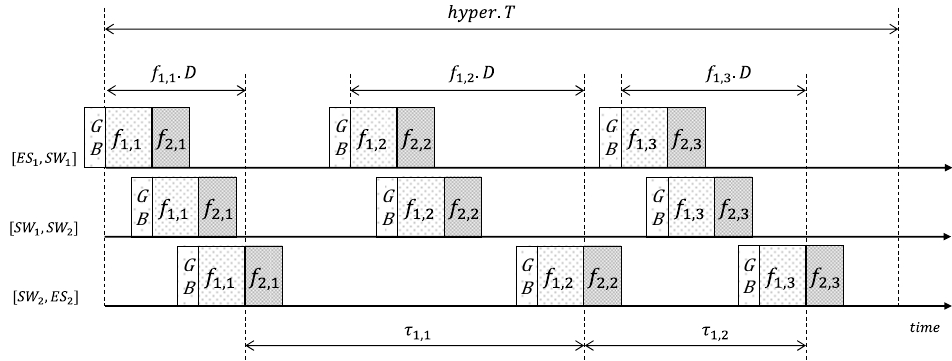
Figure 3. Example of performance indicators in a schedule represented in a Gantt chart.